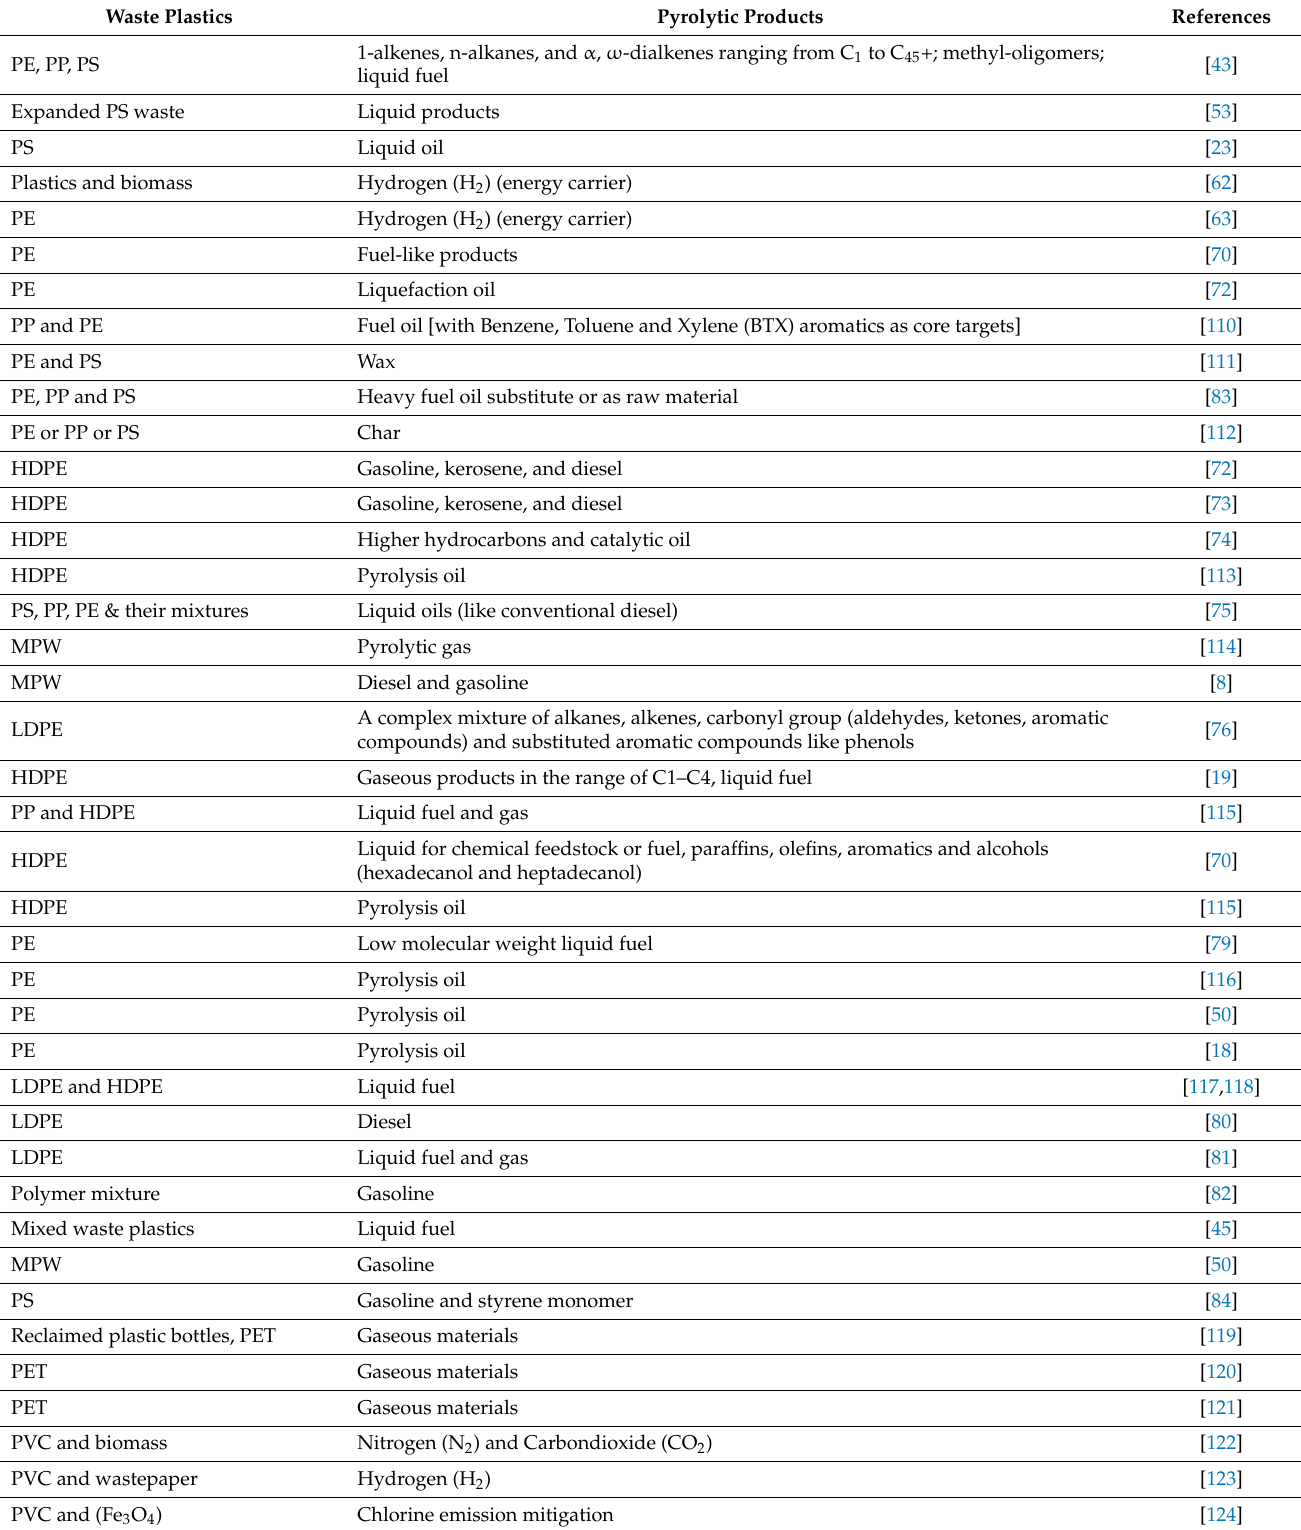
Table 2. Common waste plastic pyrolytic products. Main yields with empirical